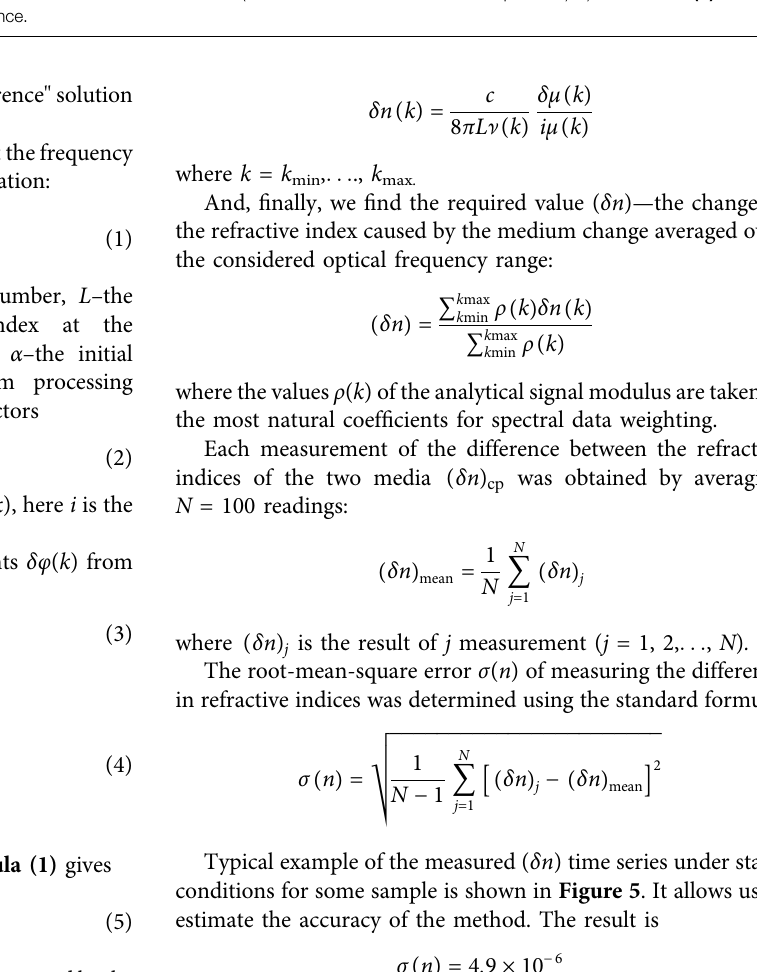
FIGURE4| Theillustrationoftheprocessingalgorithm.1)Themodulusofthecorrelationfunction(Fouriertransformofthemeasuredspectrum).2)Themodulus (A) and the phase (B) of the analytical signal frequency